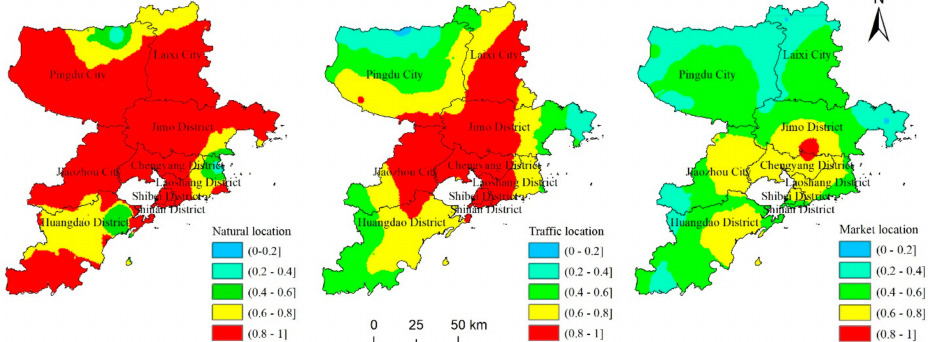
Figure 6. Spatial distribution of point–axis–domain three-dimensional